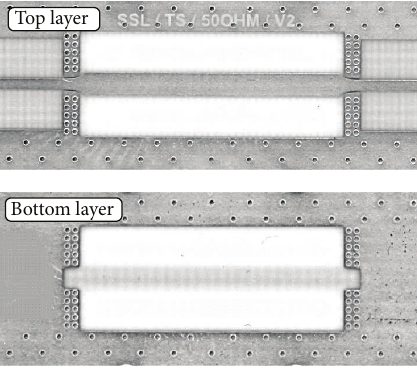
Figure 6: Picture of the fabricated high-pass